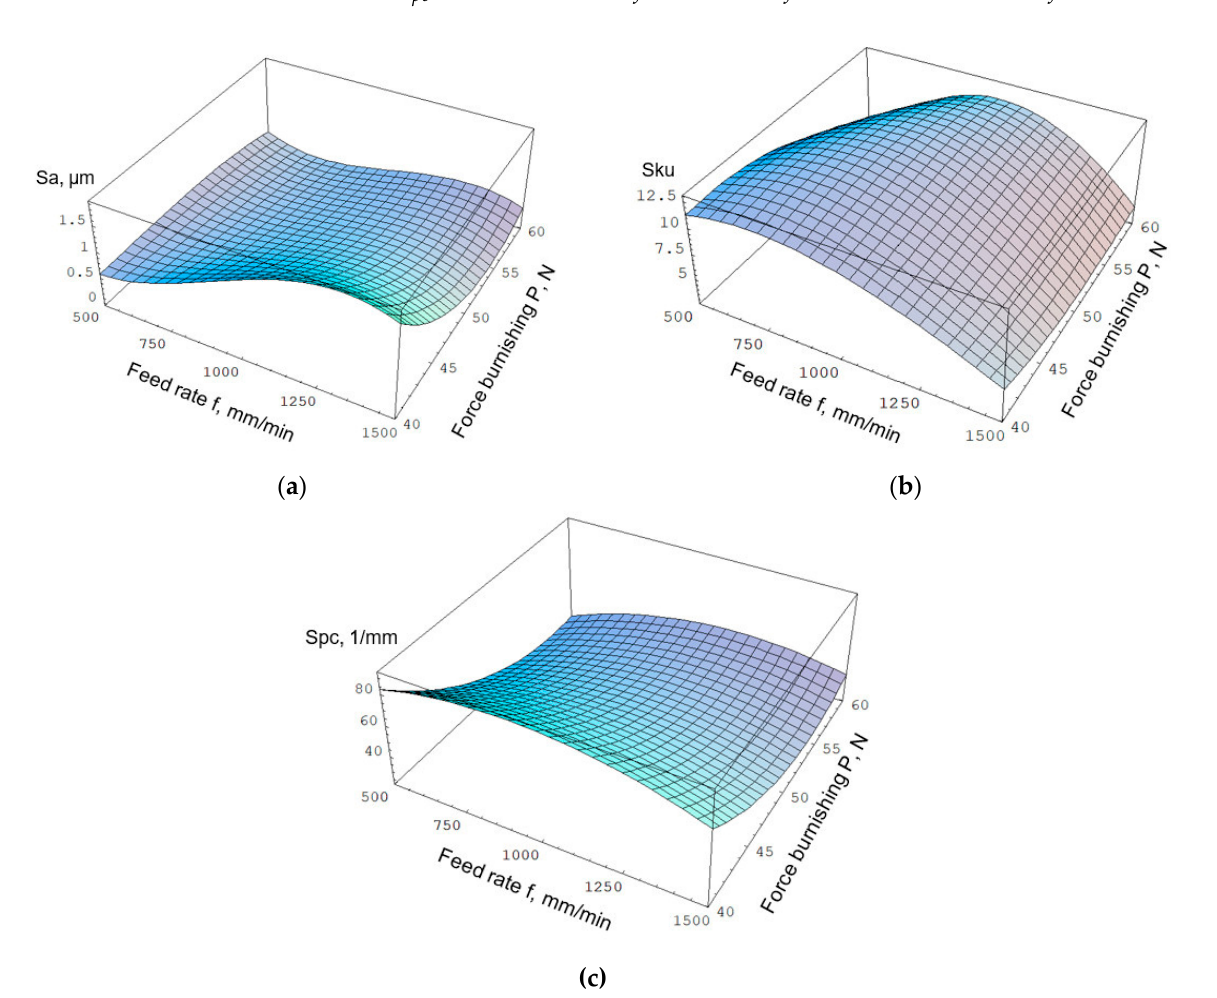
Figure 10. Plot of the regression functions of roughness parameters: ( a ) Sa, ( b ) Sku, ( c ) Spc.